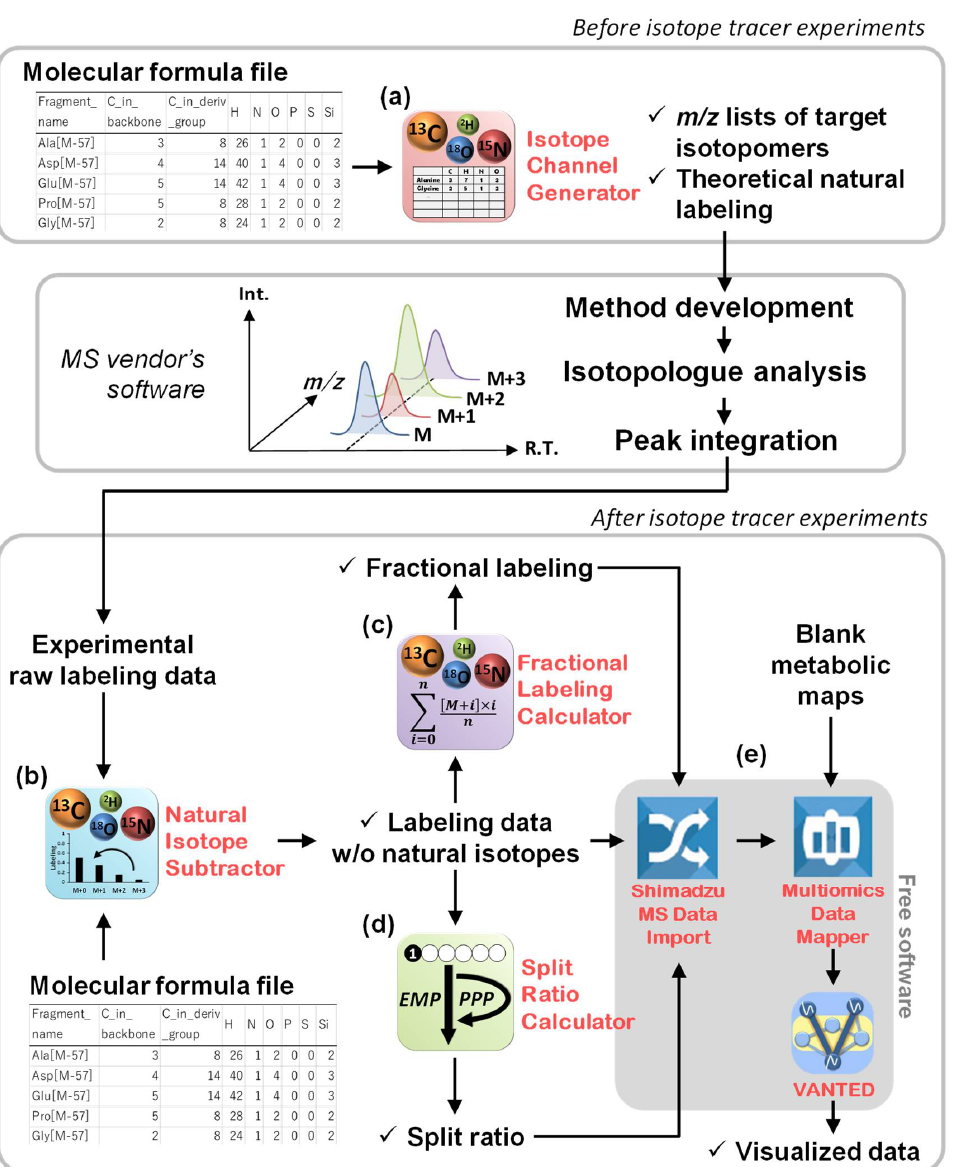
Figure 1. Overview of the Isotope Calculation Gadgets. The workflows of the ( a ) isotope channel generator, ( b ) natural isotope subtractor, ( c ) fractional labeling calculator, ( d ) split ratio calculator, and ( e ) free software for data mapping are illustrated.